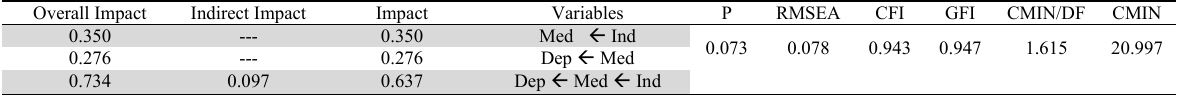
Results of Testing the Fourth Hypothesis Based on Path Analysis in